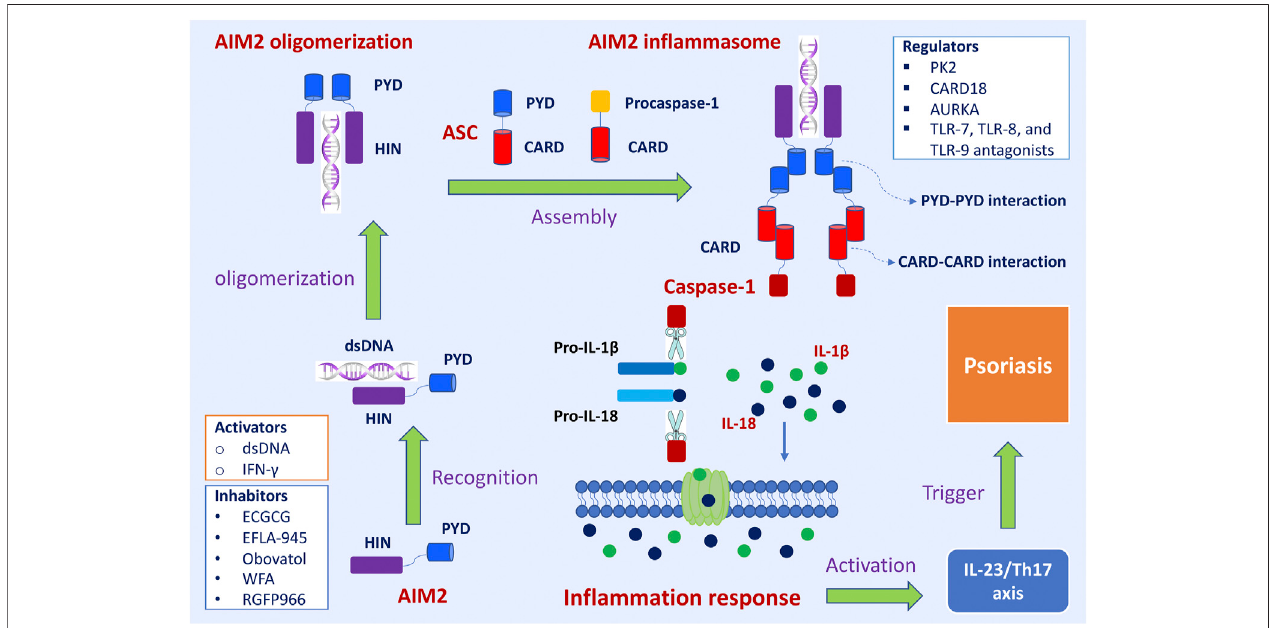
FIGURE 1 | The assembly and activation of AIM2 in fl ammasome and subsequently regulatory and trigger pathways in psoriasis. Upon sensing viral DNA, self- derived dsDNA, and cytosolic bacterium, the HIN domain of AIM2 directly recognizes dsDNA in a sequence-independent manner, which triggers the assembly of the AIM2 oligomerization. The PYD domain of AIM2 interacts with the PYD of a recruiting adapter protein ASC, resulting in a high polymer complex AIM2 in fl ammasome. Inactive procaspases-1 are recruited into AIM2 in fl ammasome via the CARD-CARD interaction. When the main components of the in fl ammasome are connecting and the active in fl ammasome is formed, it directly recruits and cleaves pro-caspase1 into active caspase-1, which proteolytically activates the pro-in fl ammatory cytokines IL-1 β and IL-18. These in fl ammatory cytokines directly induce in fl ammatory responses and participate in the occurrence and development of diseases. The activeIL-1 β andIL-18involveinIL23/Th17pathway andtheninducemanykindsofchemokinesandin fl ammatorycytokines,whichtriggerthedevelopmentofpsoriasis. Interferon-gamma (IFN- γ ) promoted the expression of the AIM2 gene. Epigallocatechin gallate (EGCG), EFLA-945, obovatol, withaferin A (WFA), and RGFP966